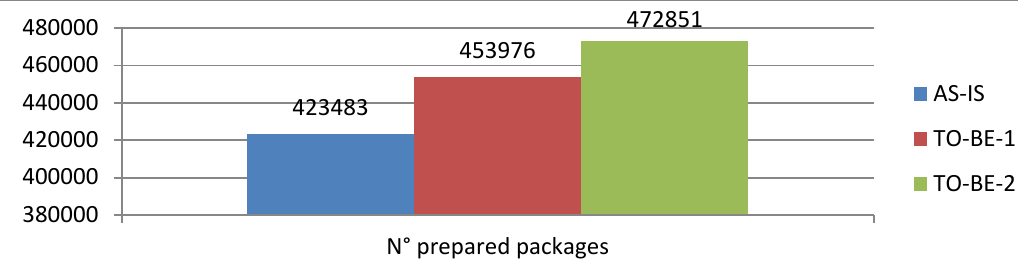
Fig. 9. Scenarios